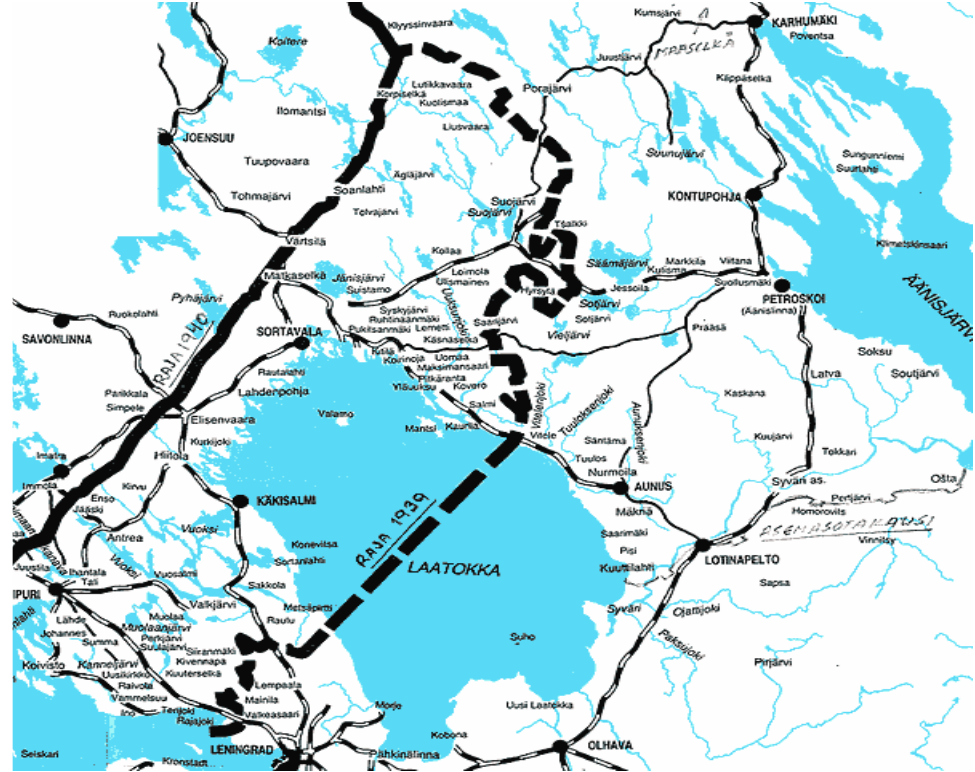
Figure 2 – Map of Republic of Karelia in Finnish [18, P.